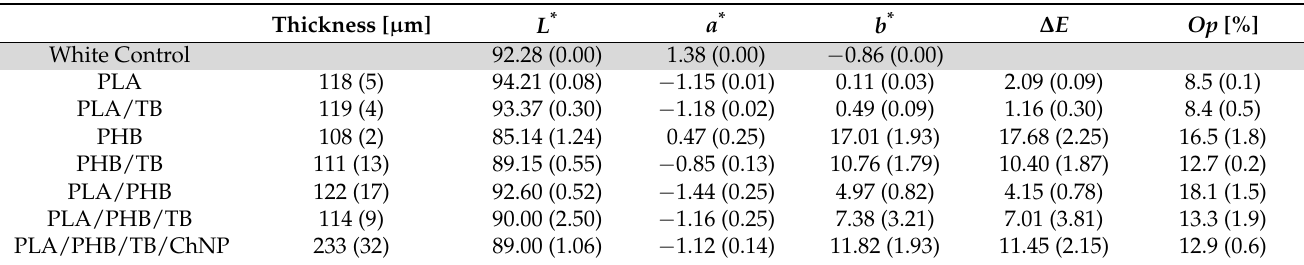
Table 3. Thickness, color parameters ( L ∗ : lightness, a ∗ : green–red, b ∗ : blue–yellow), and opacity for PLA- and PHB-based materials (values in brackets correspond to the standard